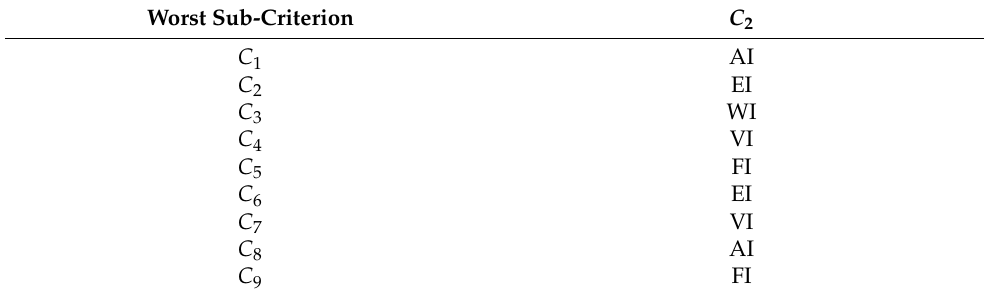
Table 5. Fuzzy reference comparisons for the worst sub-criterion C 2 .